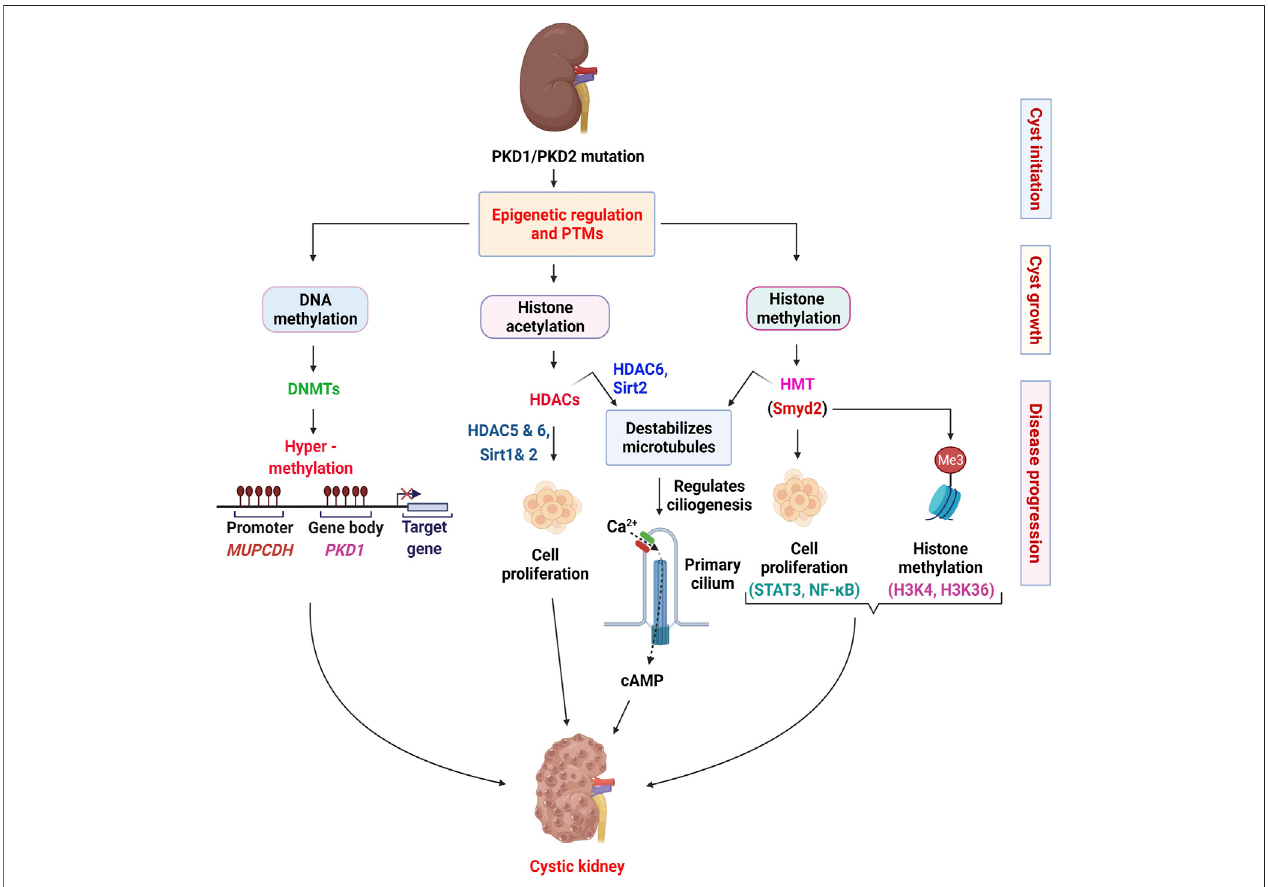
FIGURE 1 | Epigenetic mechanisms implicated in the pathogenesis of ADPKD. In this scheme, we summarize the roles of DNA methyl transferases (DNMTs), histonedeacetylases(HDACs),andhistonemethyltransferases(HMTs)inrenalepithelialcells.WeindicatetherolesofDNMTsinregulatingthetranscriptionof PKD1 and MUPCDH genes. In general, we indicate the HDACs and the HMT involved in regulating cell proliferation associated pathways. We also depict the role of HDACs and HMTsinregulatingciliogenesisthroughdeacetylationof α -tubulin(HDAC6andSIRT2)andmethylationof α -tubulin(Smyd2).Theinvolvementofcalciumsignalingin these processes is possible but uncertain. The various stages of ADPKD (cyst initiation, cyst growth and disease progression) require different epigenetic controls and therefore may require different therapeutic approaches.